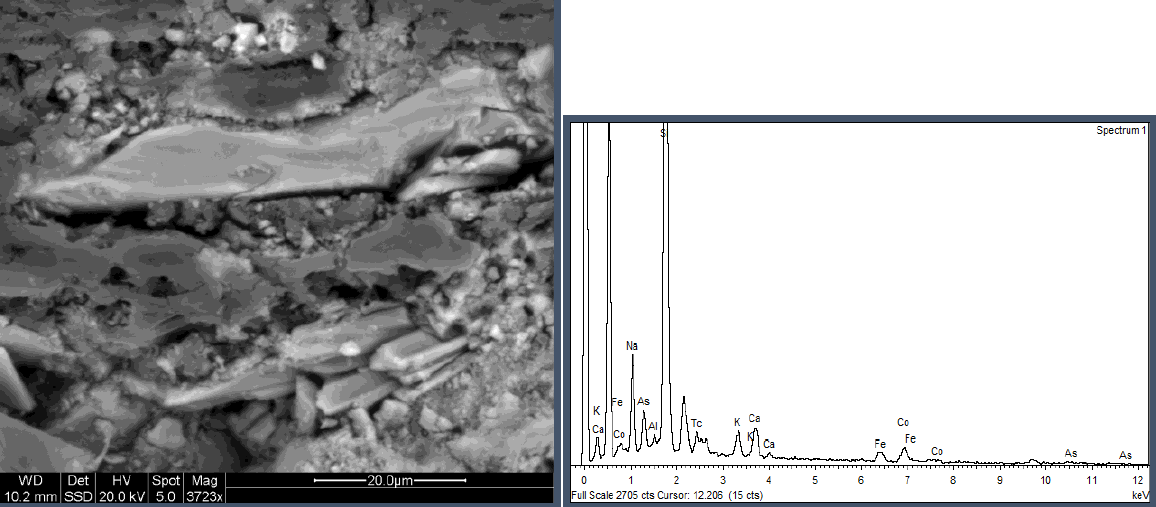
Figure 4. Scanning electron microscopy (BSE) image, taken from sample B3 ( left ), and the elemental spectrum by EDS ( right ) across this area.